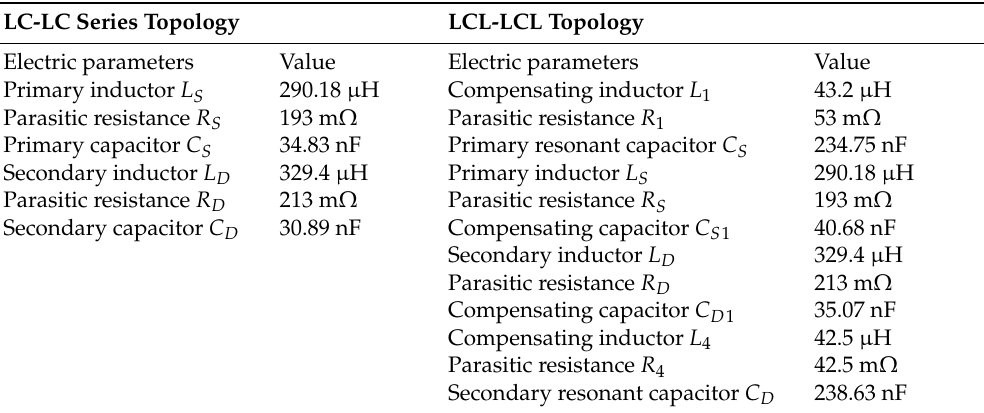
Table 1. Detailed parameters of the LC-LC series topology and LCL-LCL topology.